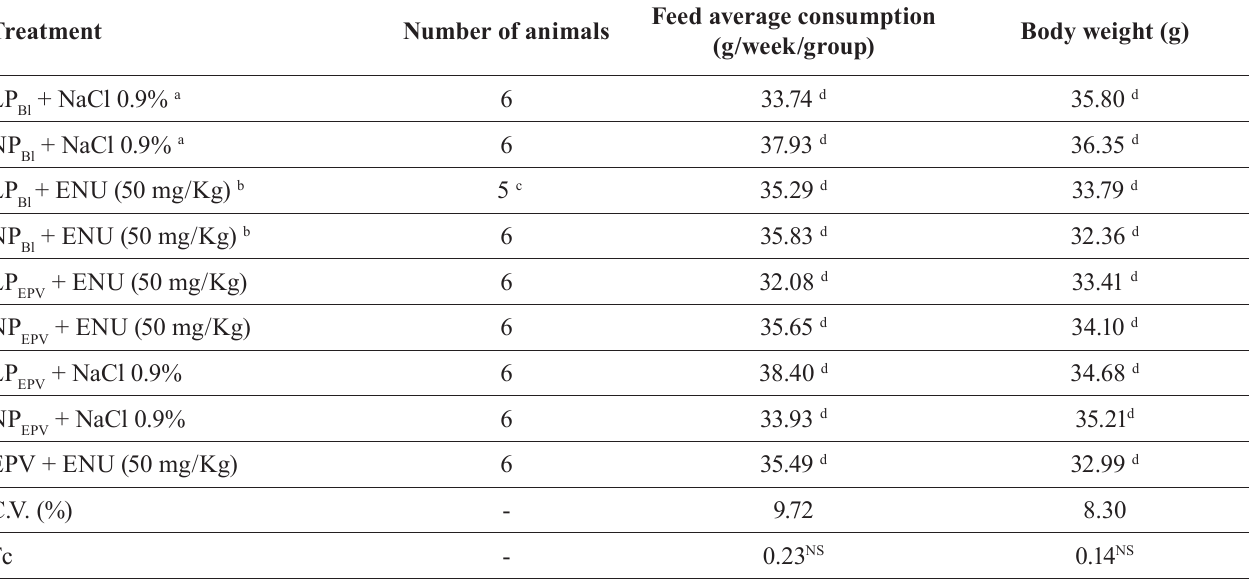
Table IV presents the feed consumption (g/week/ group) and body weight (g) during the animal treatment period. The results suggest that the treatments did TABLE IV - Feed average consumption (g/week/group) and body weight (g) of mice treated during 15 days with Pyrostegia venusta ethanolic extract Treatment Number of animals